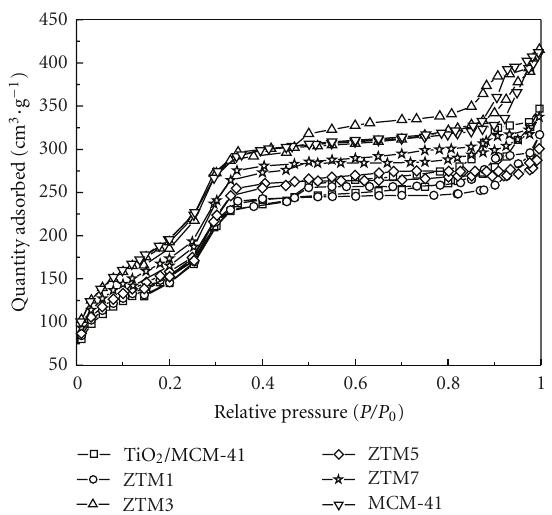
Figure 10: N 2 adsorption-desorption isotherms of MCM-41, TiO 2 /MCM-41, and ZTM series